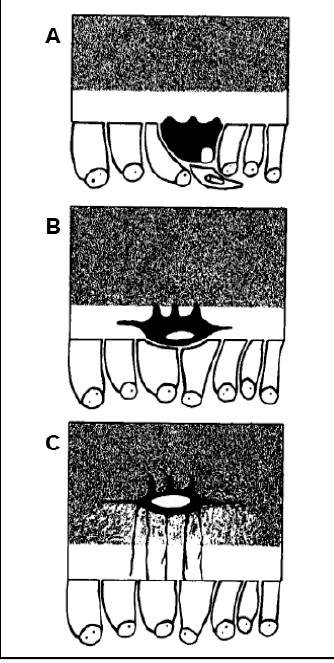
Figure 1. Schematic drawing showing the asynchronous and asymmetric pattern of cytoplasmic processes formation during osteocyte differentiation (preosteocytes = black; osteoblasts = white). ( A ) Preosteocyte enlarges its secretory territory, thus reducing its appositional growth rate, and starts to radiate processes towards the osteoid. ( B ) Preosteocyte, located inside the osteoid seam but still in contact with the osteoblastic lamina, continues to radiate short and thick cytoplasmic processes only from its mineral ‐ facing side. ( C ) Preosteocyte, before being completely buried by minerals, radiates long and slender processes from its vascular ‐ facing side to remain in touch with the osteoblastic lamina.